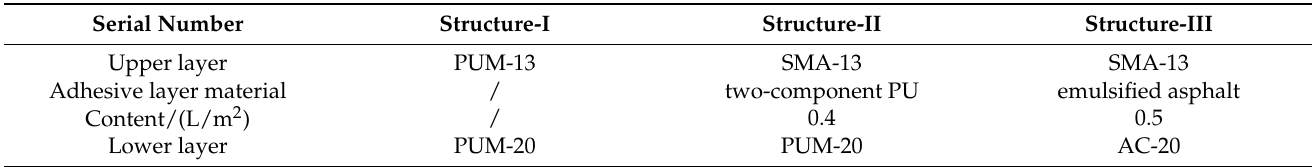
Table 3. Composite specimens of the three pavement structures.